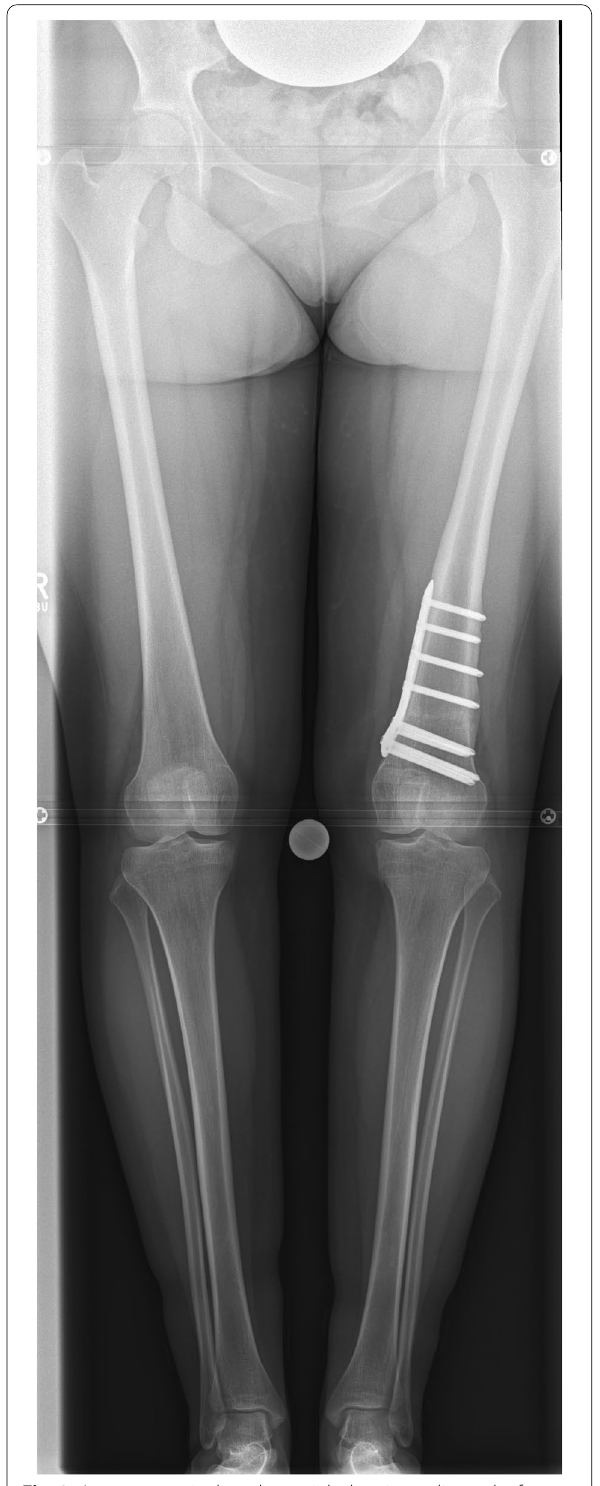
Fig. 2 Antero‑posterior long‑leg weight‑bearing radiograph after supracondylar derotation (